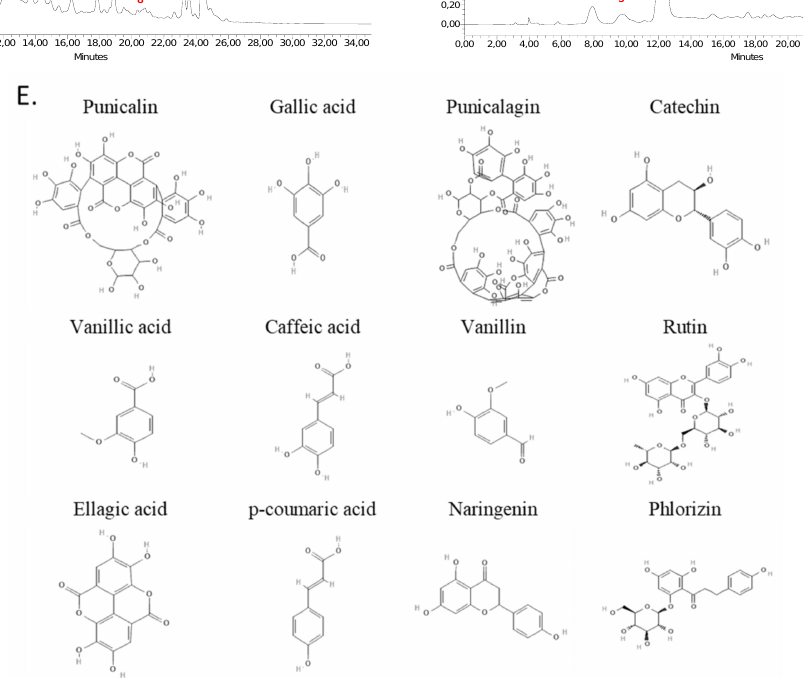
Figure 2. HPLC Chromatograms, visualized at 254 nm, of P. granatum bark Extracts: ( A ) Water (WAE), ( B ) Methanol (MEE), ( C ) Acetone(ACE), ( D ) Chloroform (CHE), and ( E ) molecular structures of the main phytochemicals:(1) Punicalin, (2) Gallic acid, (3) Punicalagin a, (4) Punicalagin b, (5) Catechin, (6) Vanillic acid, (7) Caffeic acid, (8) Vanillin, (9) Rutin, (10) Ellagic acid, (11) p-Coumaric acid, (12) Naringenin, (13)